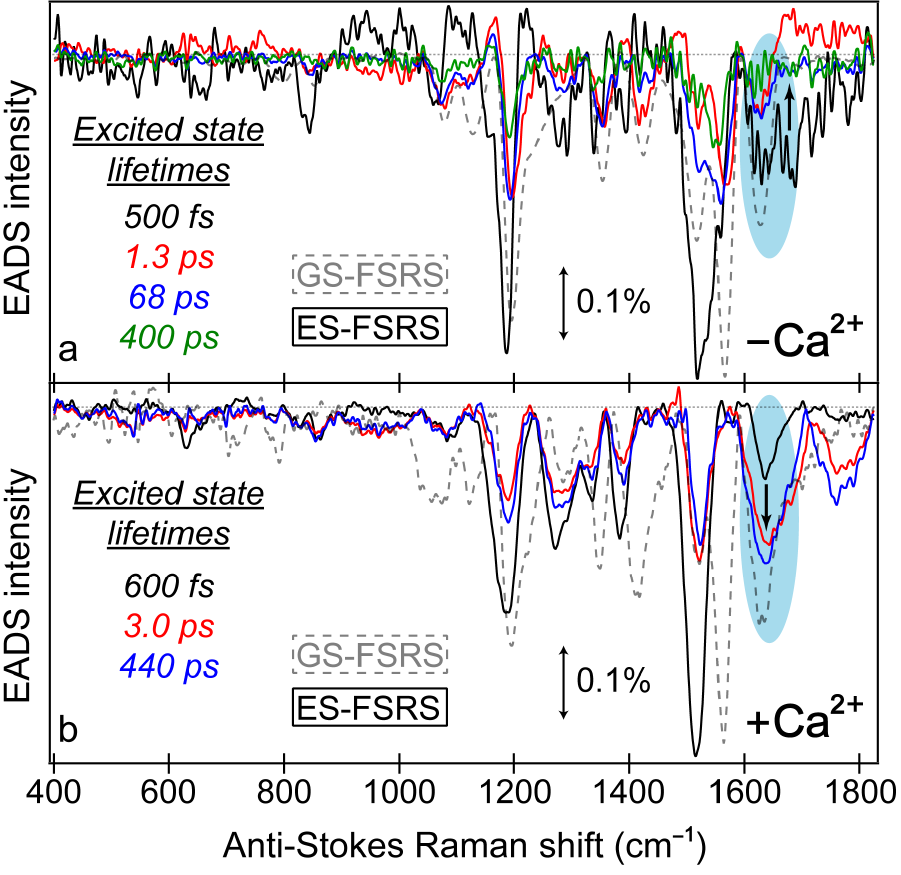
Figure 7. Global analysis of the excited-state FSRS spectra of REX-GECO1 biosensor in the ( a ) Ca 2+ - free and ( b ) Ca 2+ -bound state after 480 nm excitation with a 650 nm Raman pump (in pH 7 buffer), collected on the anti-Stokes side with a bluer Raman probe. The progression of the excited-state Raman peaks is visualized by the sequential evolution-associated difference spectra (EADS, see black → red → blue → green traces) with color-coded lifetimes (listed in the insets). Transient excited- state peaks (color-coded solid traces) are overlaid with the ground-state spectra (gray dashed traces). The double-sided arrows depict a stimulated Raman intensity of 0.1%. The cyan shaded ellipses highlight the contrasting vibrational peak dynamics above 1600 cm − 1 between the Ca 2+ -free and bound biosensors, marked by the black bolded arrow in each panel.